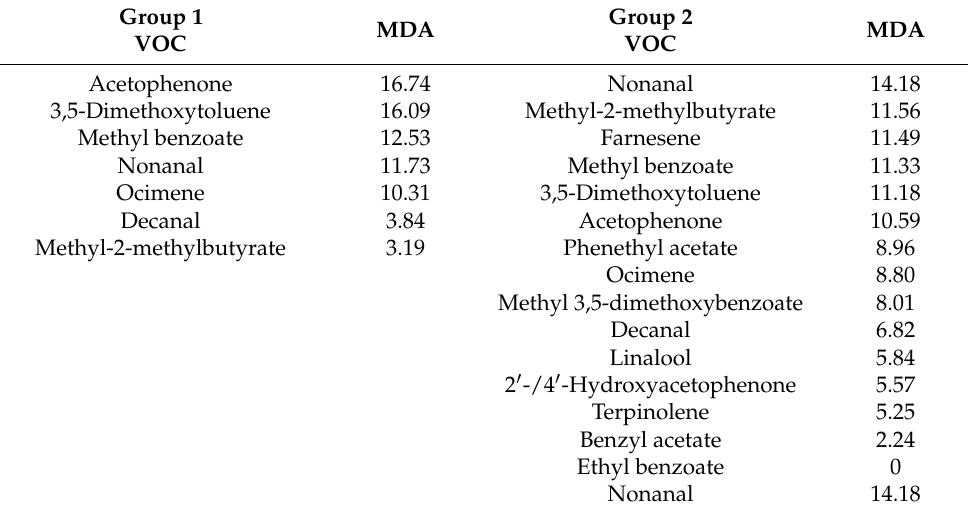
Table 3. Importance ranking of volatile organic compounds among Antirrhinum majus groups (wild-type, compacta mutant, deficiens mutant and RNAi:AmLHY) using random forest algo- rithm. The NIST library identifies two pairs of similar compounds which share the same retention time, 2 (cid:48) -Hydroxyacetophenone and 4 (cid:48) -Hydroxyacetophenone, and 2 (cid:48) -Methoxyacetophenone and 4 (cid:48) -Methoxyacetophenone, respectively. These compounds are depicted with a slash (“/”) in the table. Volatiles are ranked based on mean decrease in accuracy (MDA). This value indicates the accuracy in which a volatile can be used for